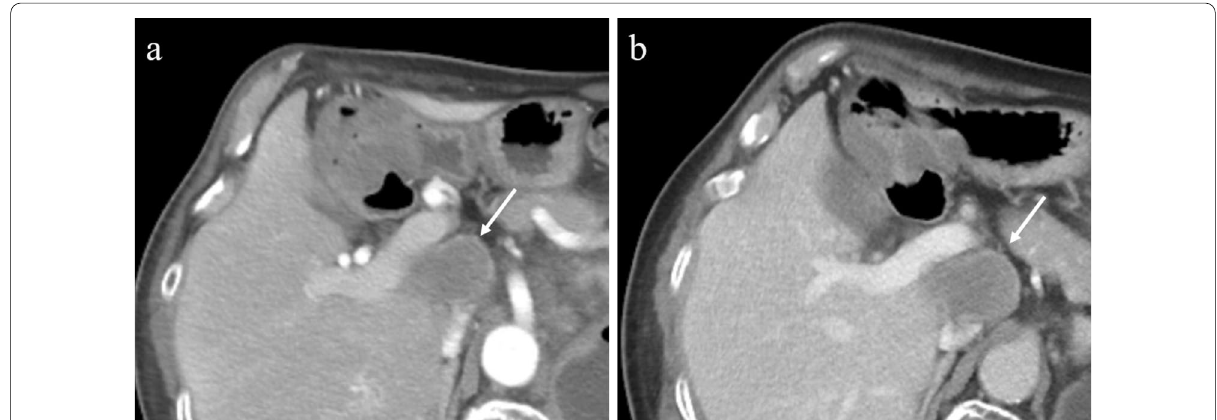
Fig. 1 Abdominal contrast-enhanced computed tomography findings. a The tumor (white arrow) measuring 40 mm showed enhancement at the peripheral margin in the arterial phase. b The tumor (white arrow) with peripheral margin enhancement was prolonged in the delayed phase